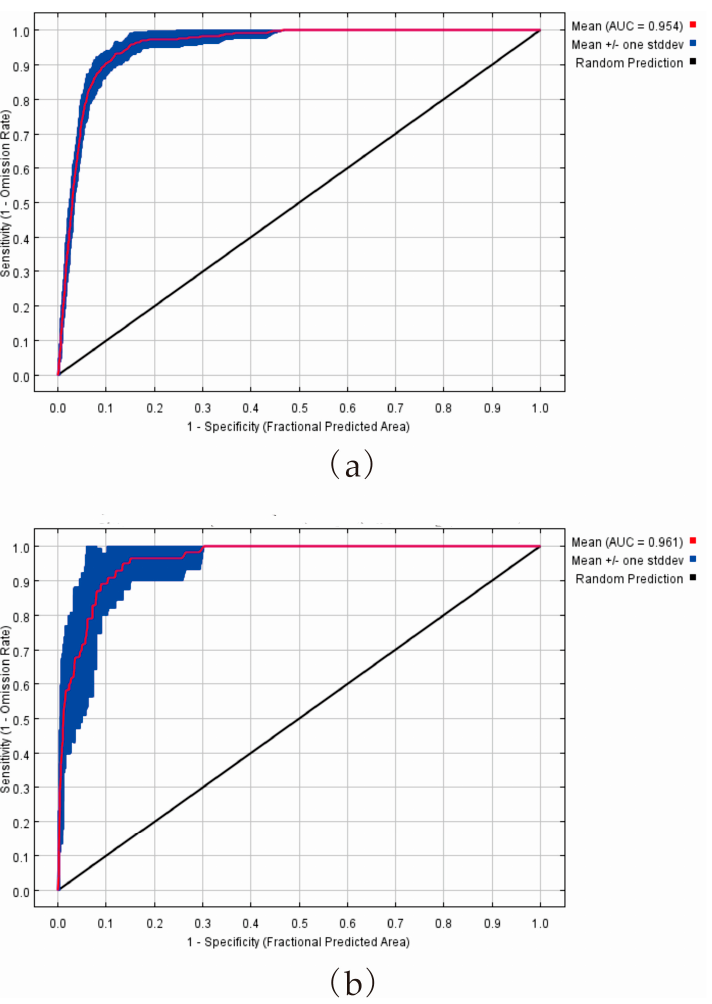
Figure 2. ROC curve and AUC values for the reconstructed model for P. salicina ( a ) and M. fructicola ( b ). The response curves presented the relationship between P. salicina and the above- selected environmental variables. Filtered by the response probability >0.66, the average temperature of the coldest quarter (bio11) was from − 3.82 to 10.36 ◦ C, the warmest quarterly precipitation (bio18) was from 404.8 to 2200 mm, the average precipitation in July (prec07) was from 131.936 to 450.368 mm, the average minimum temperature in January (tmin01) was from − 9.158 to 7.538 ◦ C, and the average minimum temperature in November (tmin11) was from − 1.251 to 10.78 ◦ C. These ranges indicated the suitable conditions for P. salicina occurrence (Figure